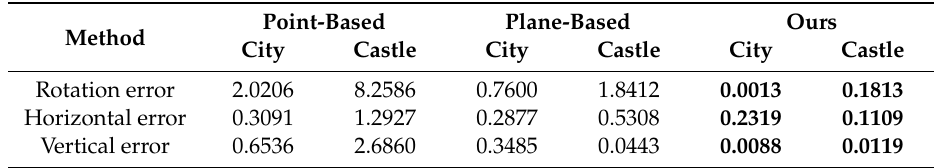
Table 3. The registration accuracy of the three methods on the outdoor dataset. The best results are denoted in bold font.